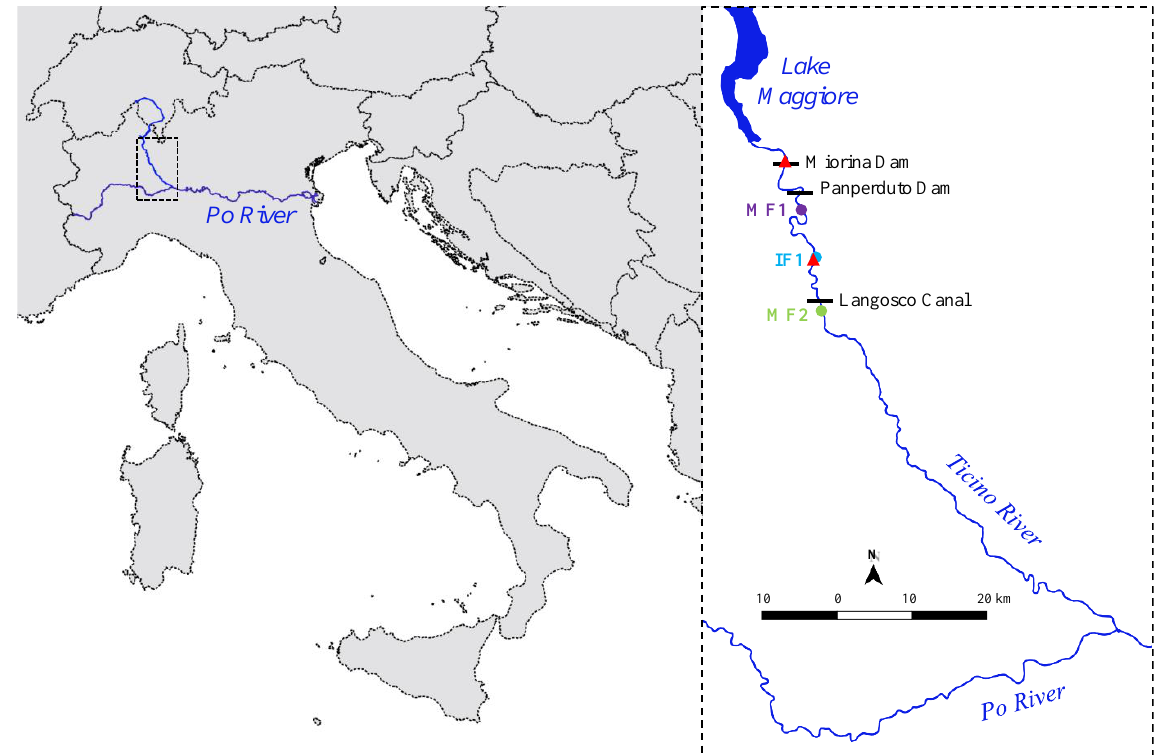
Figure 1. Study area. Position of the Ticino River, i.e., one of the main tributaries of the Po River, in Italy (left). Detail of the investigated river reach (right) downstream of Lake Maggiore with the Miorina and Panperduto dams, the intake of Langosco Canal and the three sampling sites (MF1, IF1, and MF2); flow gauging stations along the river are indicated by red triangles.